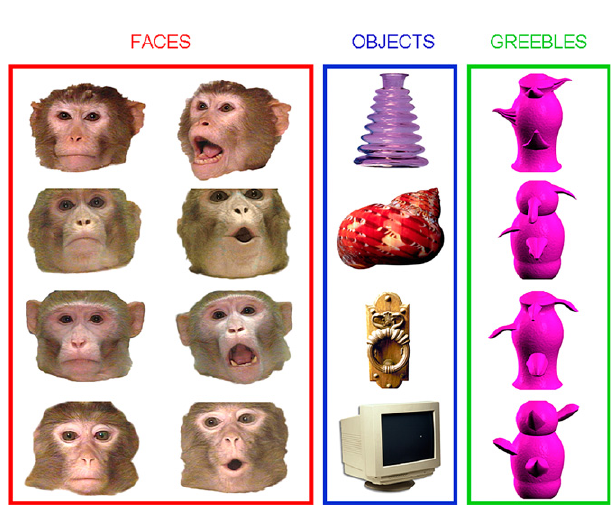
Figure 1. Examples of stimuli, grouped by category assignment. Face examples are outlined in red, with neutral faces in the left column and the respective monkey’s vocalization expression in the right column. The vocali- zation examples are composed of grunts (shown in the top example) and coos (shown in the bottom example). Clip-art object examples are shown in the blue column, and asymmetric Greeble examples in the green column.